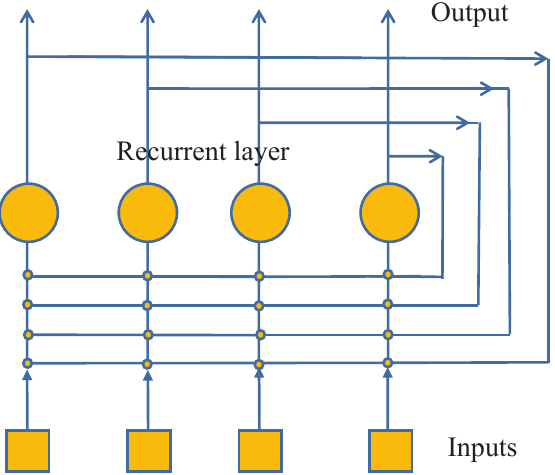
Figure 2. Architecture of a simple RNN: the inputs connect with each hidden neuron, and the hidden neurons have connections between every other neuron and have outputs.